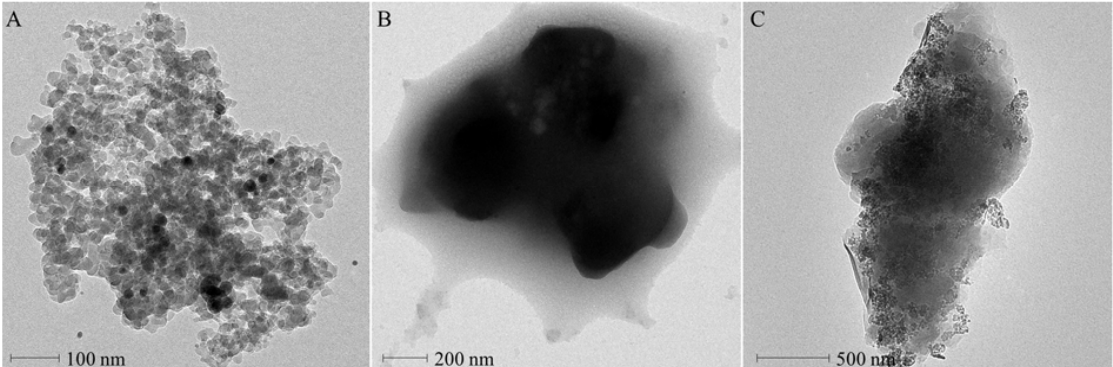
Fig. 1: Transmission electron microscopy of the additives evaluated: A) AgNp_silica, B) Ag + _phosphate and C) Ag +